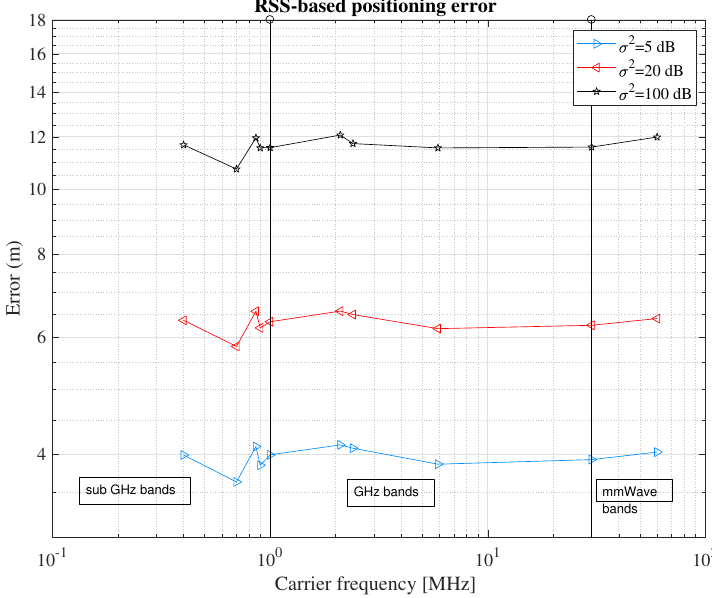
Figure 1. Comparative analysis of RSS-based estimates at various carrier frequencies and various AN